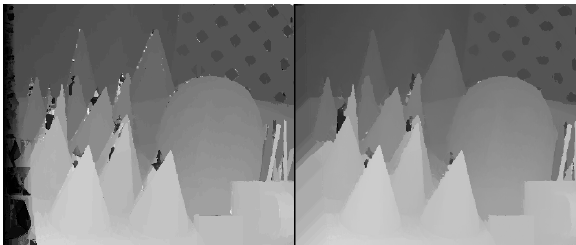
Figure 8. Disparity map of the left Cone image before (left) and after (right) the overall